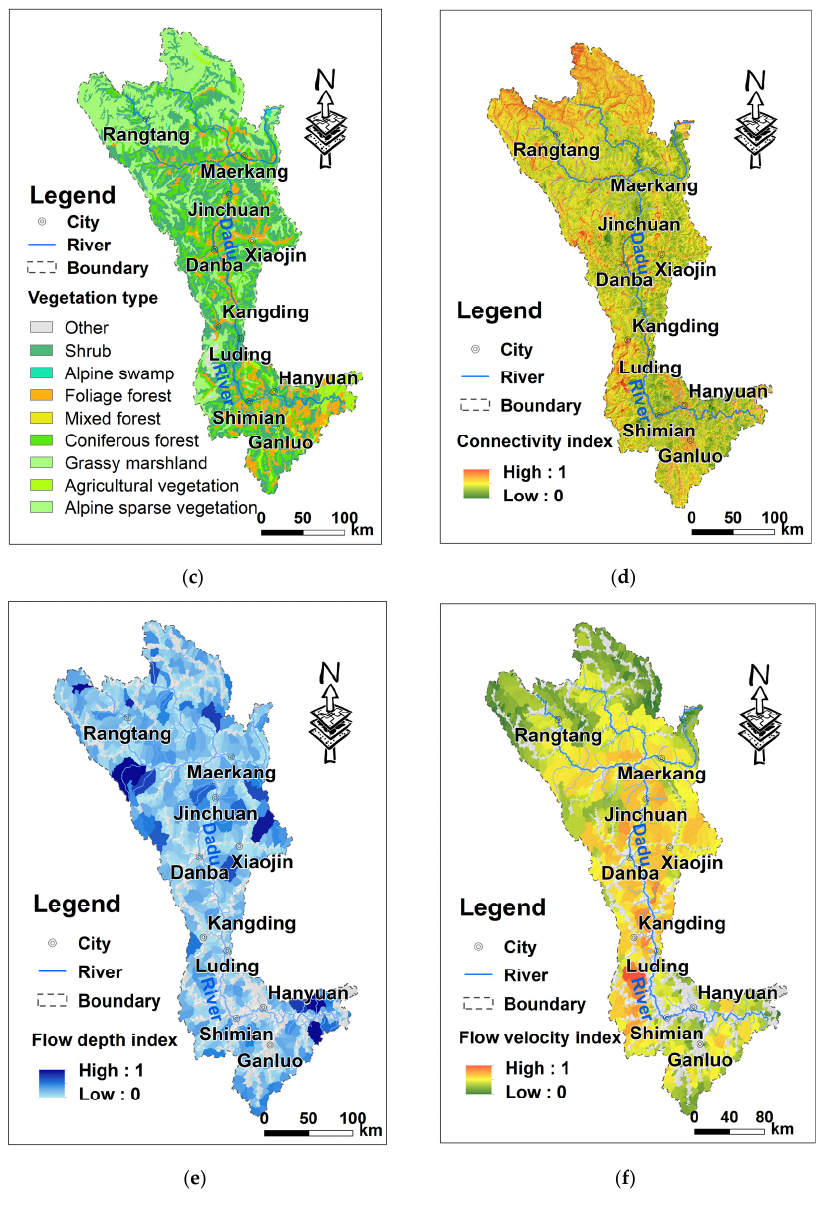
Figure 6. The data used for the susceptibility prediction: ( a ) the soil mass strength, ( b ) soil mass thickness, ( c ) vegetation types, ( d ) channel connectivity, ( e ) flow depth, and ( f ) runoff velocity.